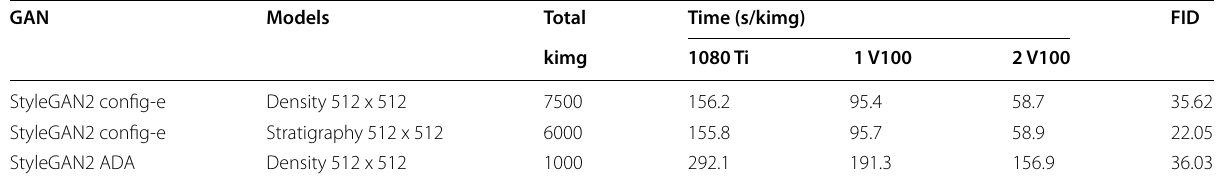
Table 1 Training statistics and final FID scores of our GAN models. The term “kimg” refers to thousands of real images shown to the network and thus defines the length of the training